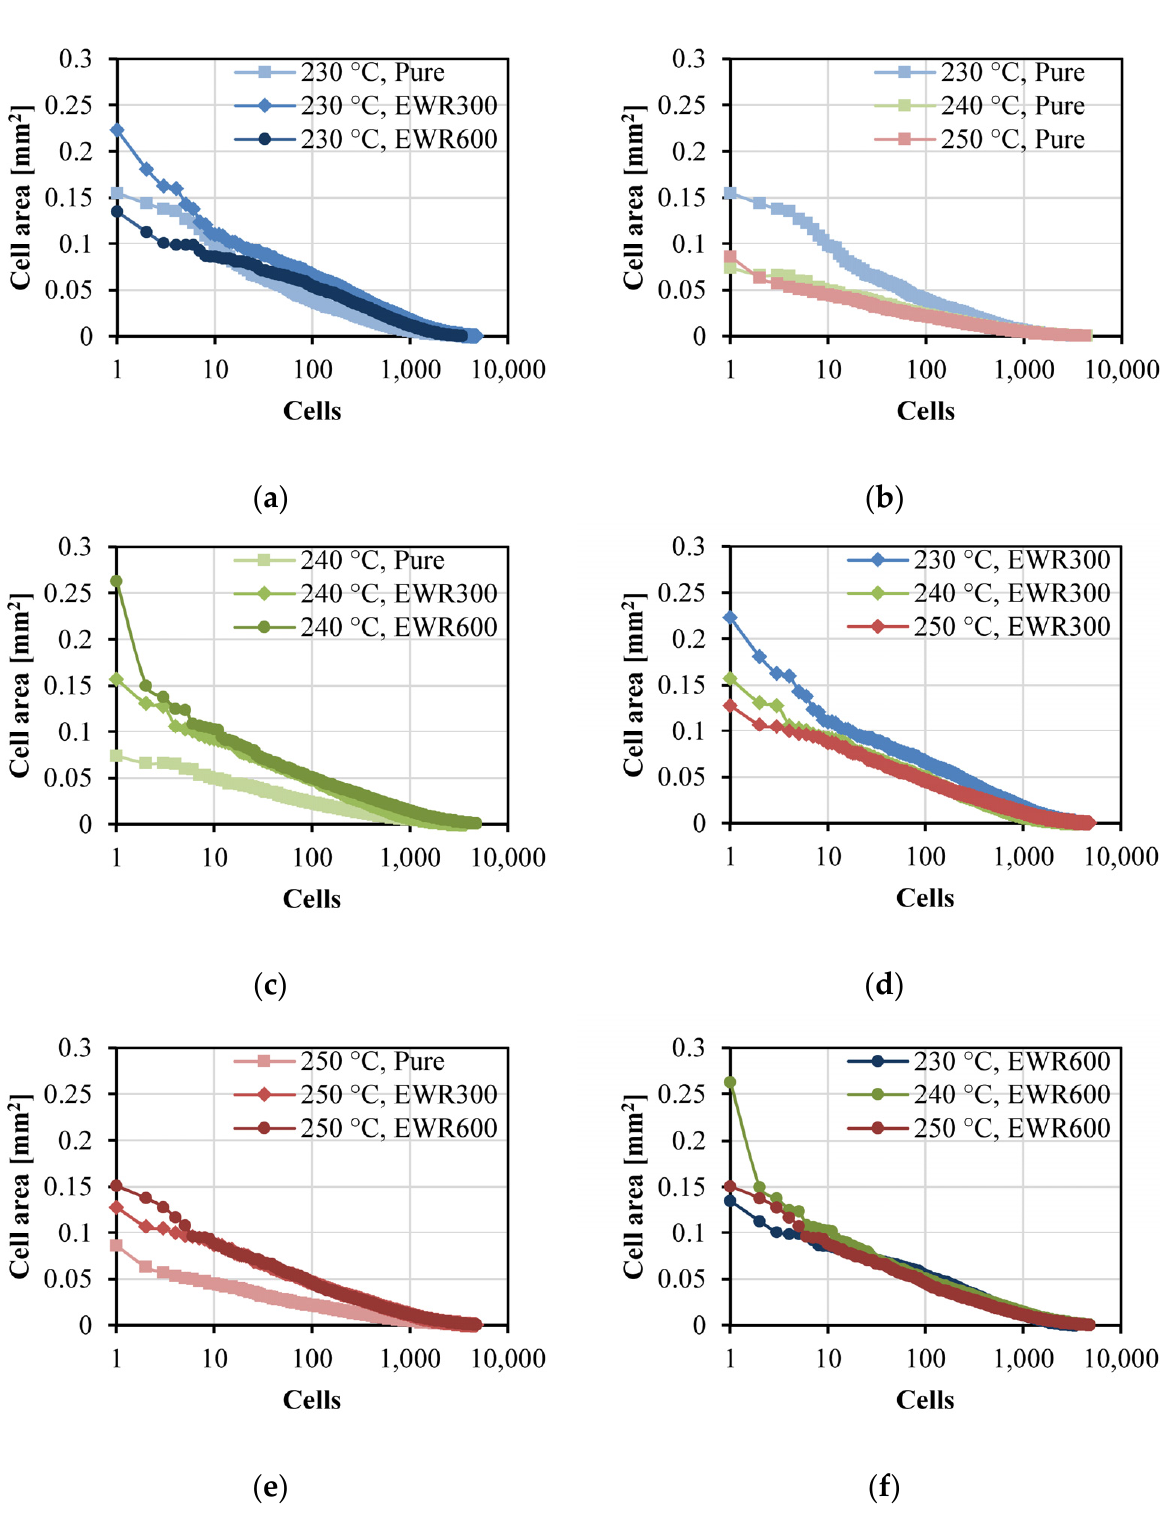
Figure 9. The average cell size ( a ) and cell density ( b ) of the tensile samples with foaming.